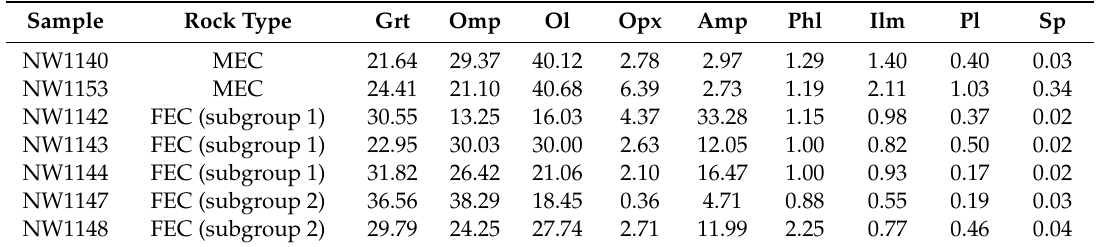
Table 1. Normalized phase volume proportions (vol.%) based on electron backscatter di ff raction (EBSD) mapping.